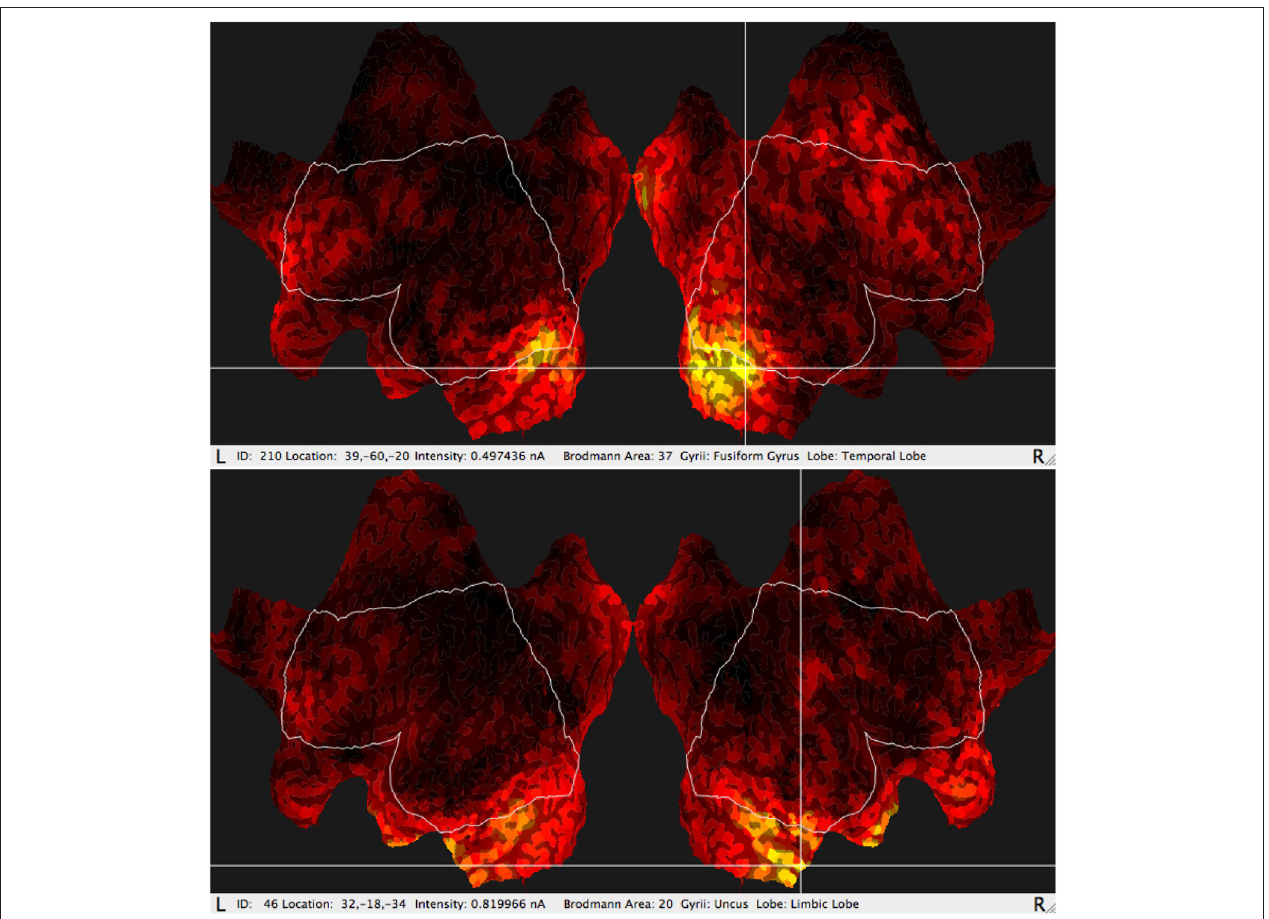
FIGURE 3 | Typical results of GeoSource BA activity visualization on the brain cortex so-called Flat Map. The increase of activity in BA37 (Fusiform Gyrus, Temporal Lobe) and BA20 (Uncus Lobe, Limbic Lobe) is indicated.